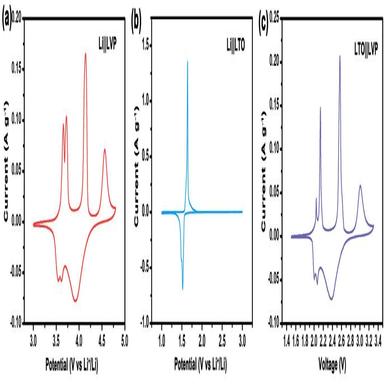
Typical CV curves of (a) Li||LVP, (b) Li||LTO and (c) LTO||LVP cells.